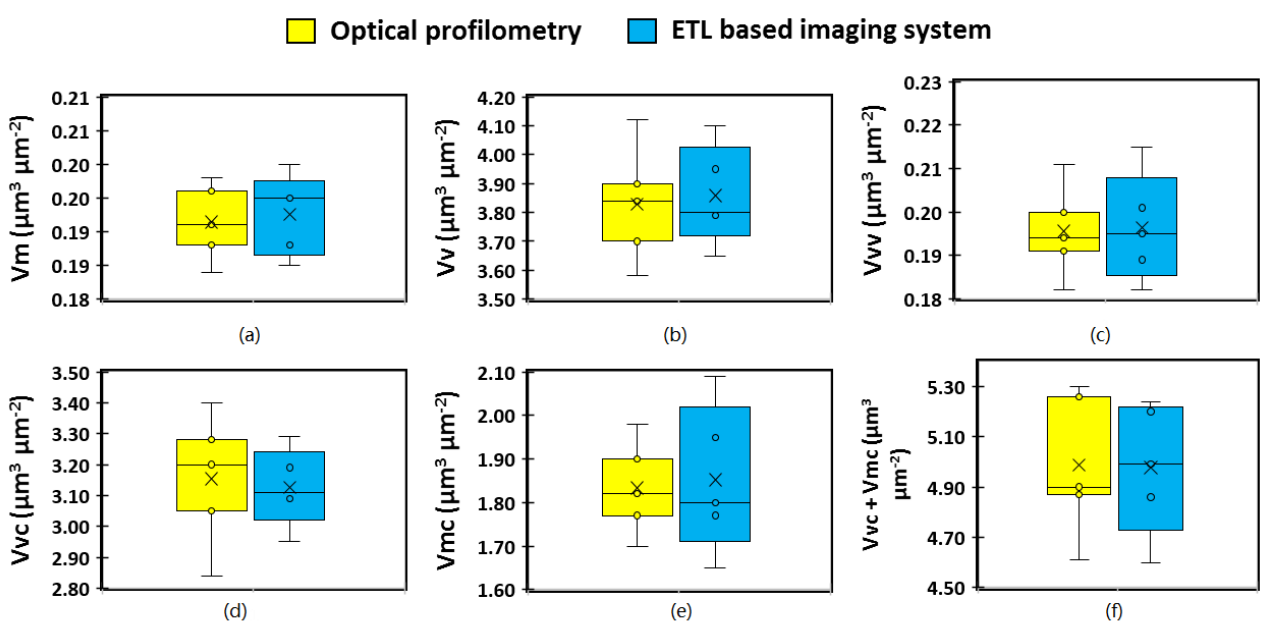
Figure 10. Spatial parameters of 3D surface texture analysis. ( a ) V m : material surface volume; ( b ) V v : surface void volume; ( c ) V vv : valley void volume; ( d ) V vc : core void volume; and ( e ) V mc : core material surface volume; ( f ) V vc + V mc : core void plus core material surface.